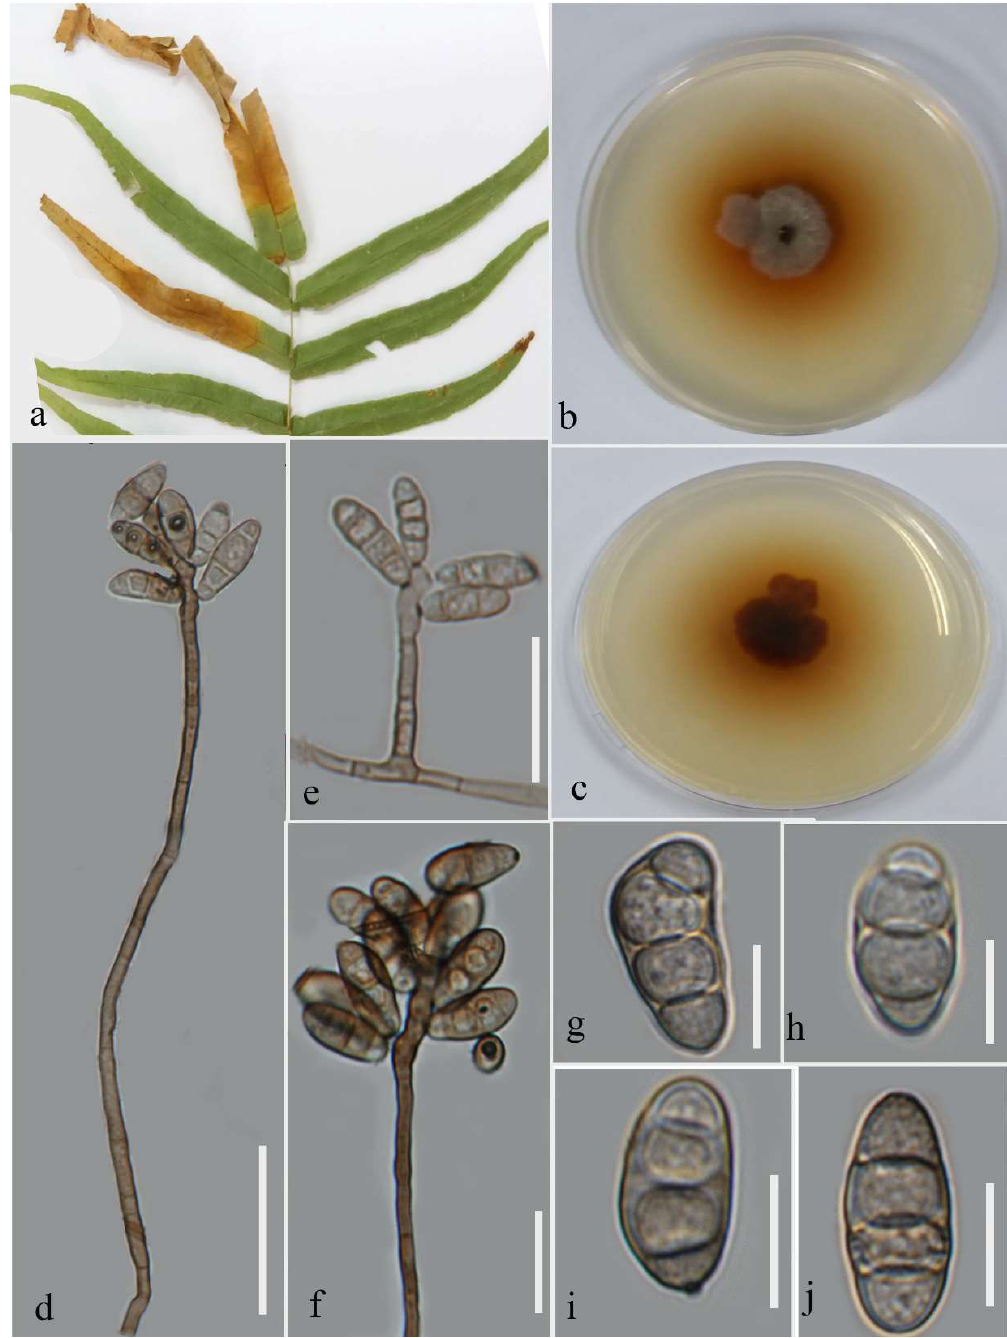
Figure 4. Morphology of Curvularia lunata (MFLUCC 22 - 0142): ( a ) blight on Pteris grandifolia ; ( b , c ) upper and reverse views of the culture after seven days on PDA at 28 °C; ( d – f ) conidiophores and sympodial conidiogenous cells; ( g – j ) conidia . Scale bars ( d ) = 50 µm, ( e – f ) = 25 µm, and ( g – j ) = 10 µm . Sordariomycetes O.E. Erikss. &